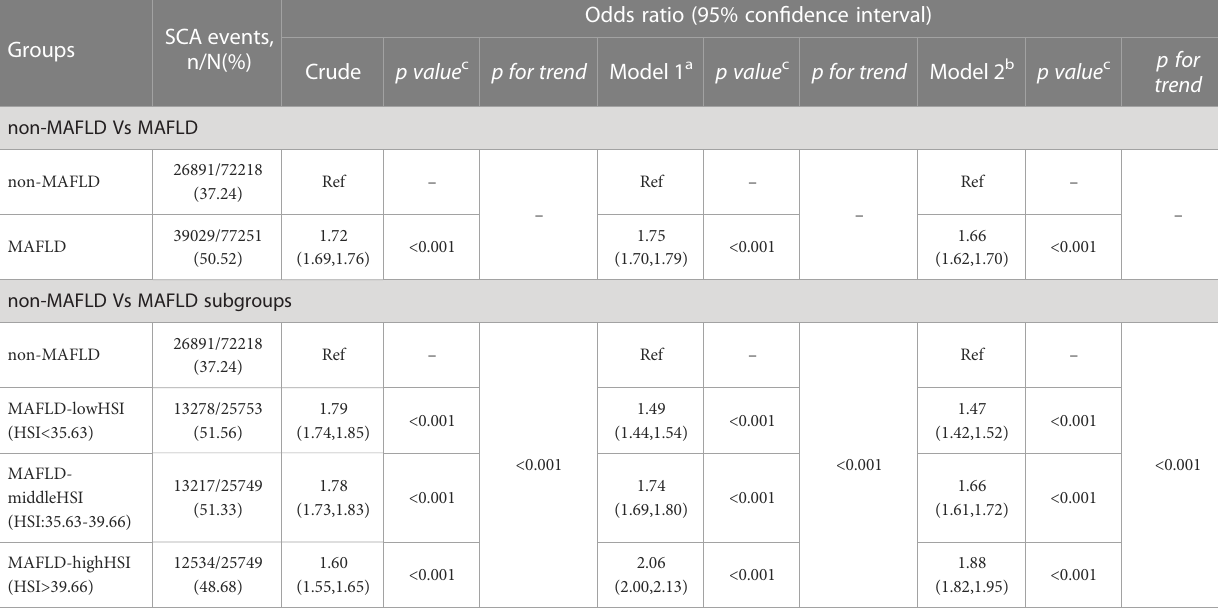
TABLE 2 Association between MAFLD and subclinical carotid atherosclerosis in the cross-sectional analysis.